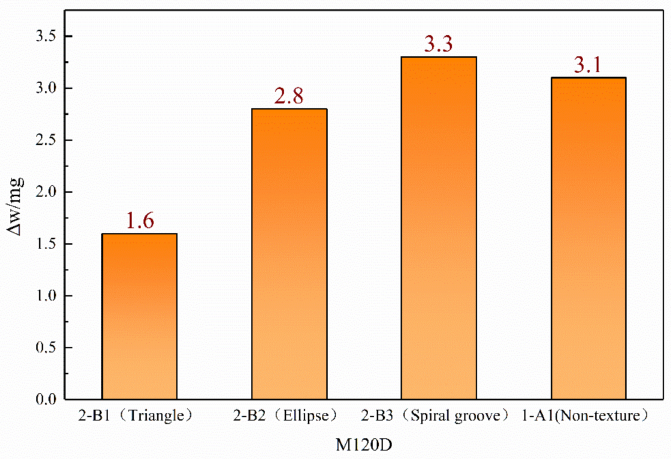
Figure 8. Wear quantity of M120D with texture and